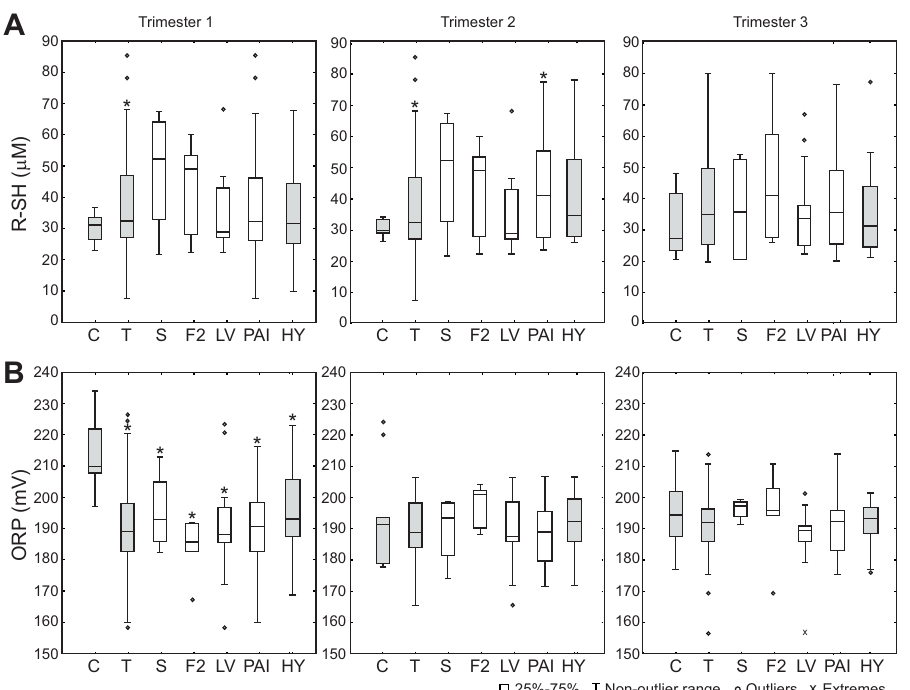
Fig 3. Redox settings in the plasma in different trimesters. ( A ) Concentration of reduced thiols. ( B ) Static ORP of plasma. C–control (n = 10 for each trimester); T–thrombophilias (all; n = 56); S–protein S deficiency (n = 4); F2 – F2 gene mutation (n = 6); LV–Factor V Leiden mutation (n = 13); PAI– PAI -1 polymorphism (n = 31); HY– thrombophilic pregnancies burdened with hypertension (n = 20). Boxes represent the median and the 25 th and 75 th percentiles; whiskers represent the non-outlier range; circles–outliers; x—extremes. � —Statistically different compared to control (p < 0.05). There was no statistical difference between values obtained at different trimesters of thrombophilic